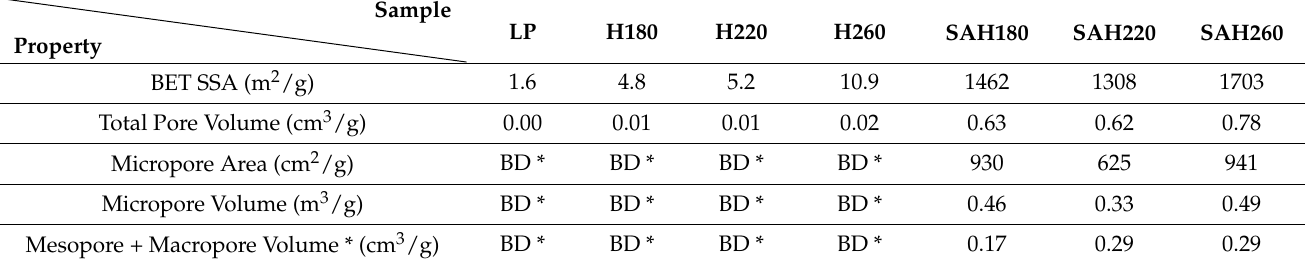
Table 1. Surface porosity characterization of LP, corresponding hydrochars and activated